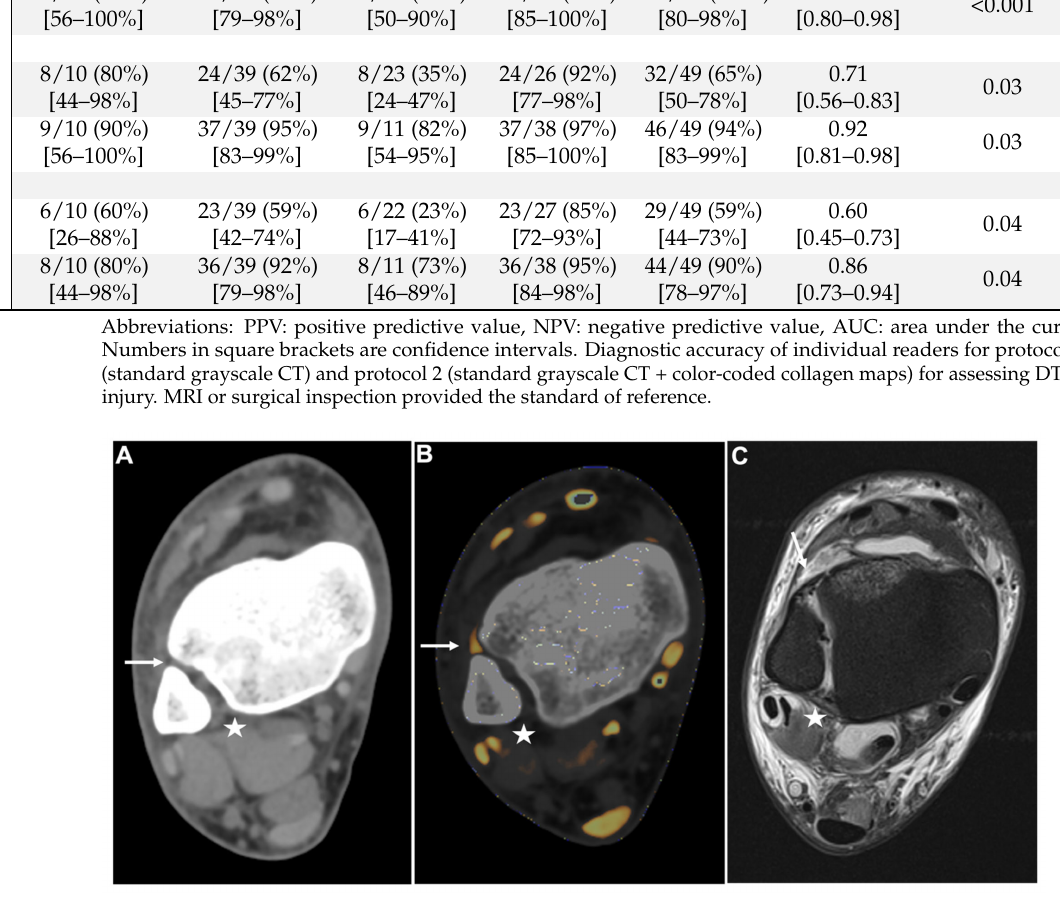
Figure 4. PTIFL strain. Standard axial unenhanced grayscale CT ( A ), color-coded collagen recon- structions ( B ), and proton density-weighted unenhanced MRI series with fat saturation ( C ) of a patient with an ankle sprain. While the ATIFL ( arrow ) and PTIFL ( star ) are visible in the grayscale images, no diagnostic assessment of both ligaments is accurately possible. After collagen mapping, the ATIFL is visible and intact ( arrow ) . However, no collagen signal can be acquired for the PTIFL ( star ), suggestive of rupture. MRI images show an intact ATIFL ( arrow ) and a partial tear of the PTIFL ( star ), which likely caused a drop of the collagen content below acquirable thresholds. Abbreviations: ATIFL, anterior tibiofibular ligament. PTIFL, posterior tibiofibular